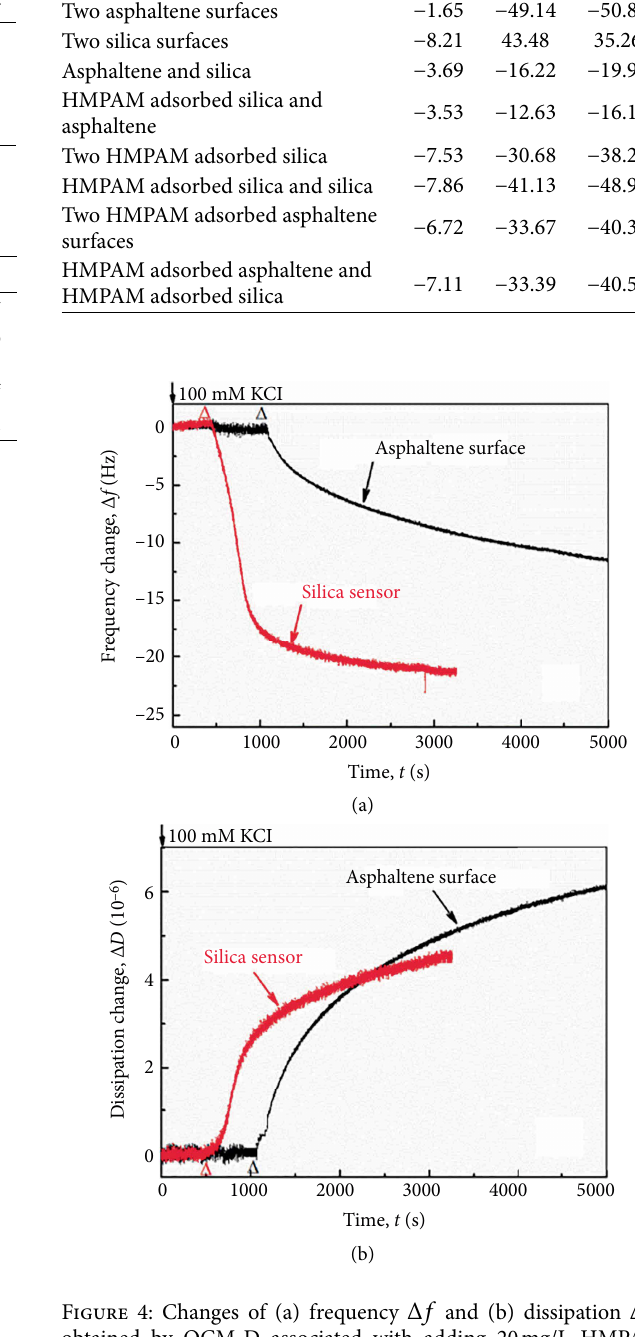
Figure 4: Changes of (a) frequency Δ𝑓 and (b) dissipation Δ𝐷 obtained by QCM-D associated with adding 20 mg/L HMPAM in 100 mM KCl solution on silica and asphaltene sensors. ( Δ -start